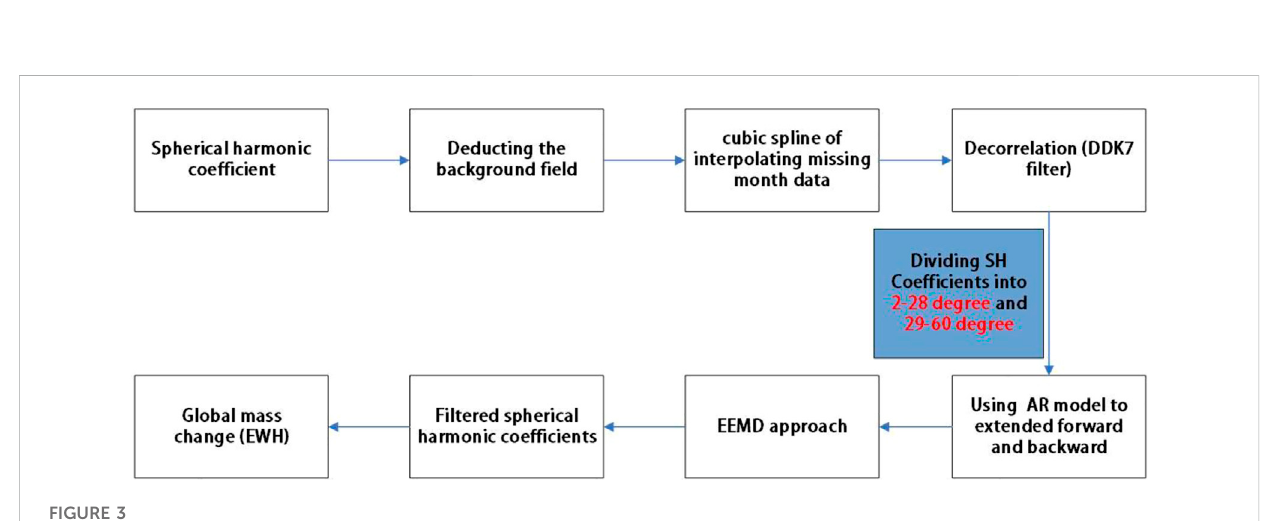
FIGURE 3 The fl owchart of EEMD for fi ltering GRACE